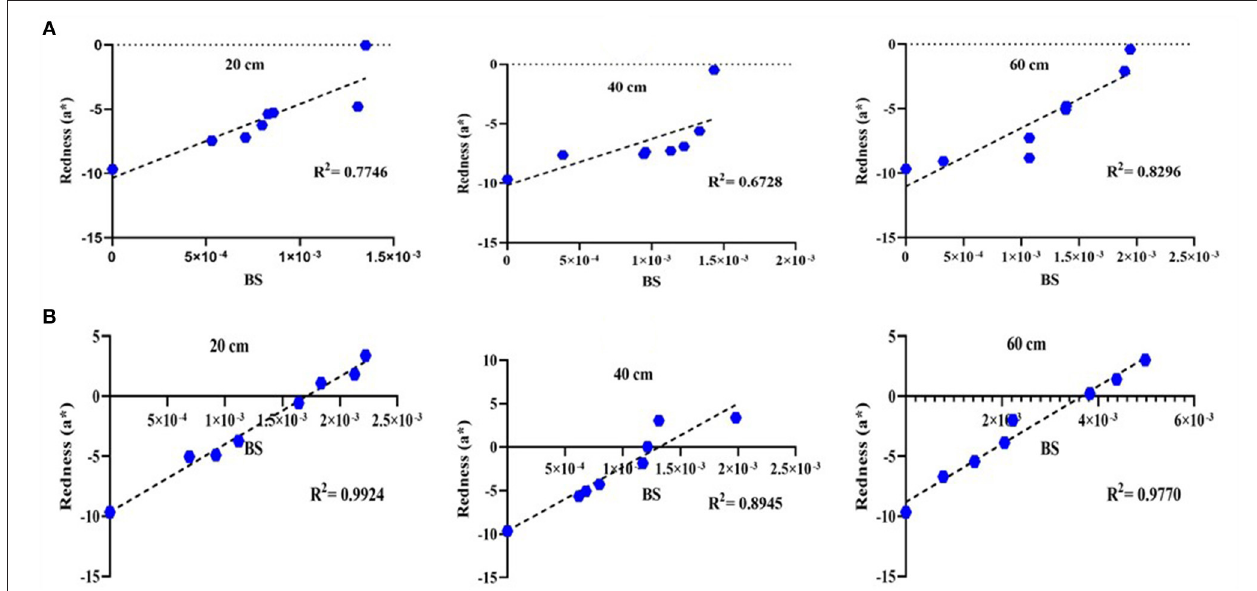
FIGURE 6 | Single linear regression between BS and a* at different drop heights (20, 40, and 60cm) during 14 days at (A) 10 ◦ C and (B) 22 ◦ C storage conditions.